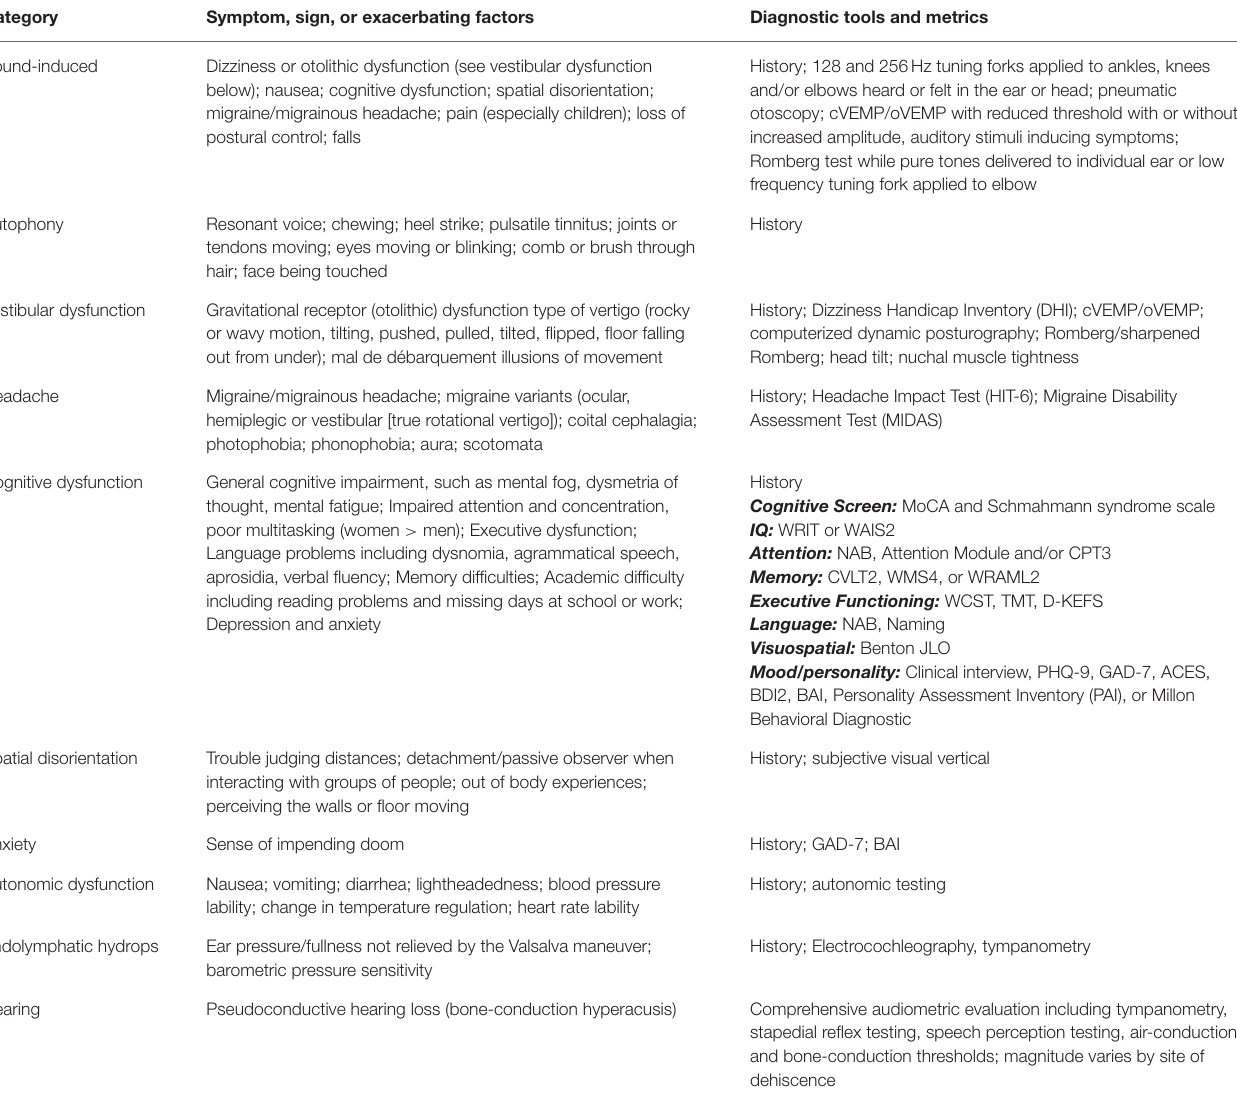
TABLE 3 | Spectrum of symptoms, signs or exacerbating factors seen in third window syndrome and diagnostic tools and metrics available to measure these clinically observed phenomenon. Category Symptom, sign, or exacerbating factors Diagnostic tools and metrics Sound-induced Dizziness or otolithic dysfunction (see vestibular dysfunction below); nausea; cognitive dysfunction; spatial